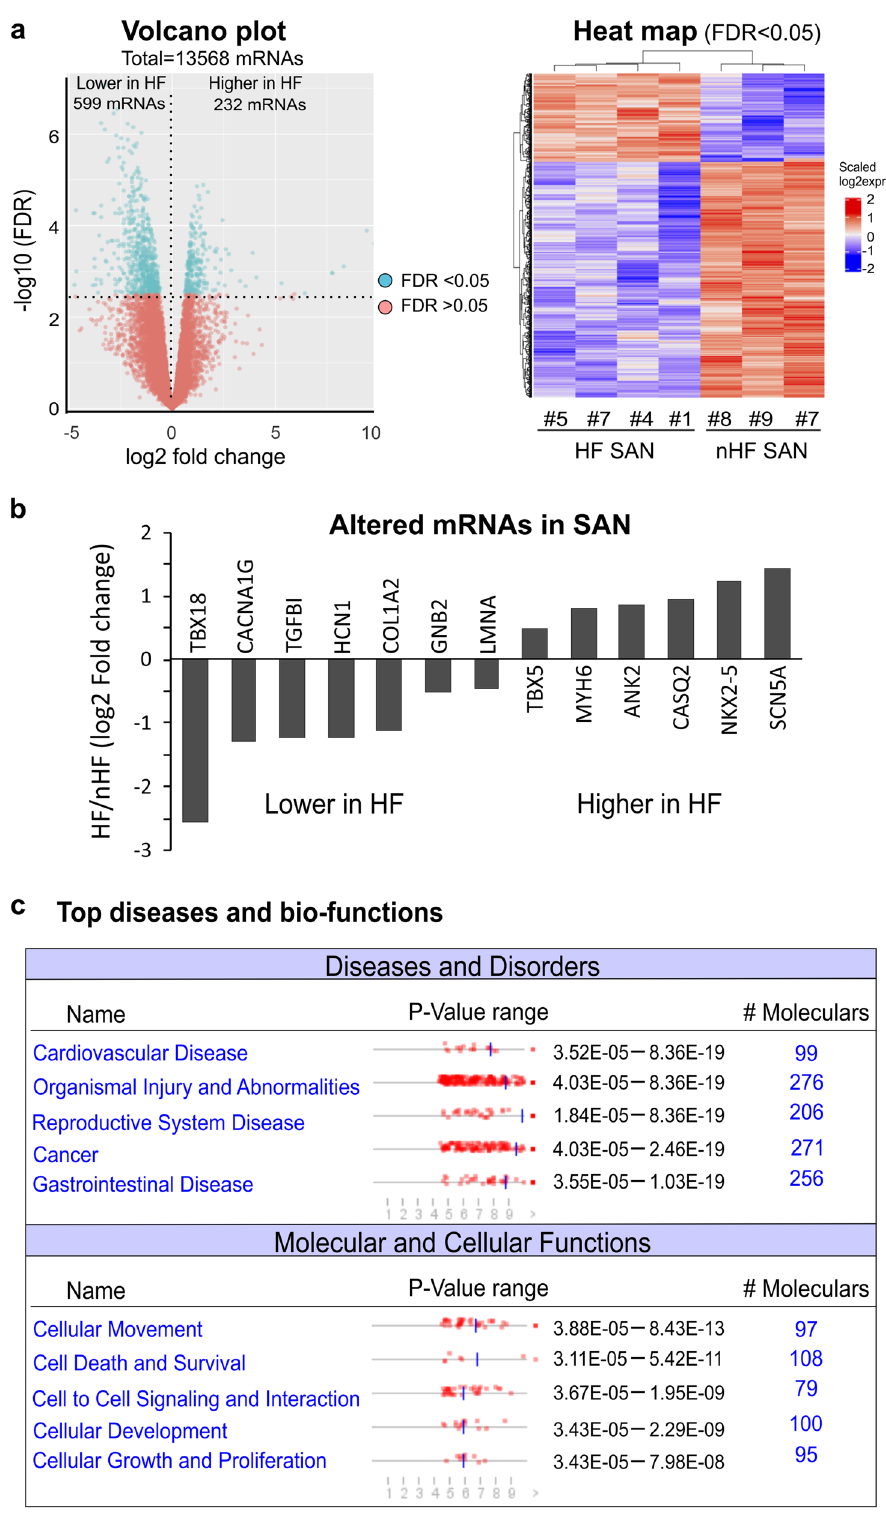
Figure 3. Altered mRNAs and related pathways in the human HF SAN. ( a ) Volcano plot (left) and heat map (right) of altered mRNAs in the HF human SAN; there are 599 mRNAs significantly downregulated and 232 mRNAs upregulated in the HF human SAN. ( b ) Bar graph shows NGS data of some significantly altered genes related to SAN dysfunction. ( c ) IPA shows the most common diseases and disorders and the top molecular and cellular functions that are related to the significantly altered mRNAs in the HF human SAN. Plots and heat maps were generated with R